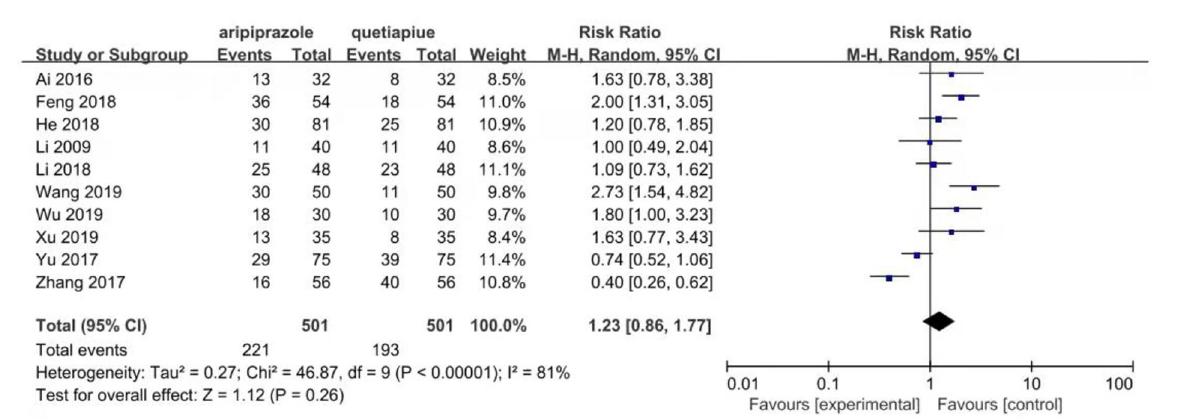
FIGURE2 Comparison of remission rate between aripiprazle group and quetiapine group. There were ten studies that reported remission rate.The random effect model was used for analysis of remission rate due to heterogeneity ( X 2 = 46.87, df = 9, p < 0.00001, I 2 = 81%). The results showed that there was no significant difference in the remission rate between aripiprazole and quetiapine in the treatment of bipolar depression (221/501 vs. 193/501, Z = 1.12, P =